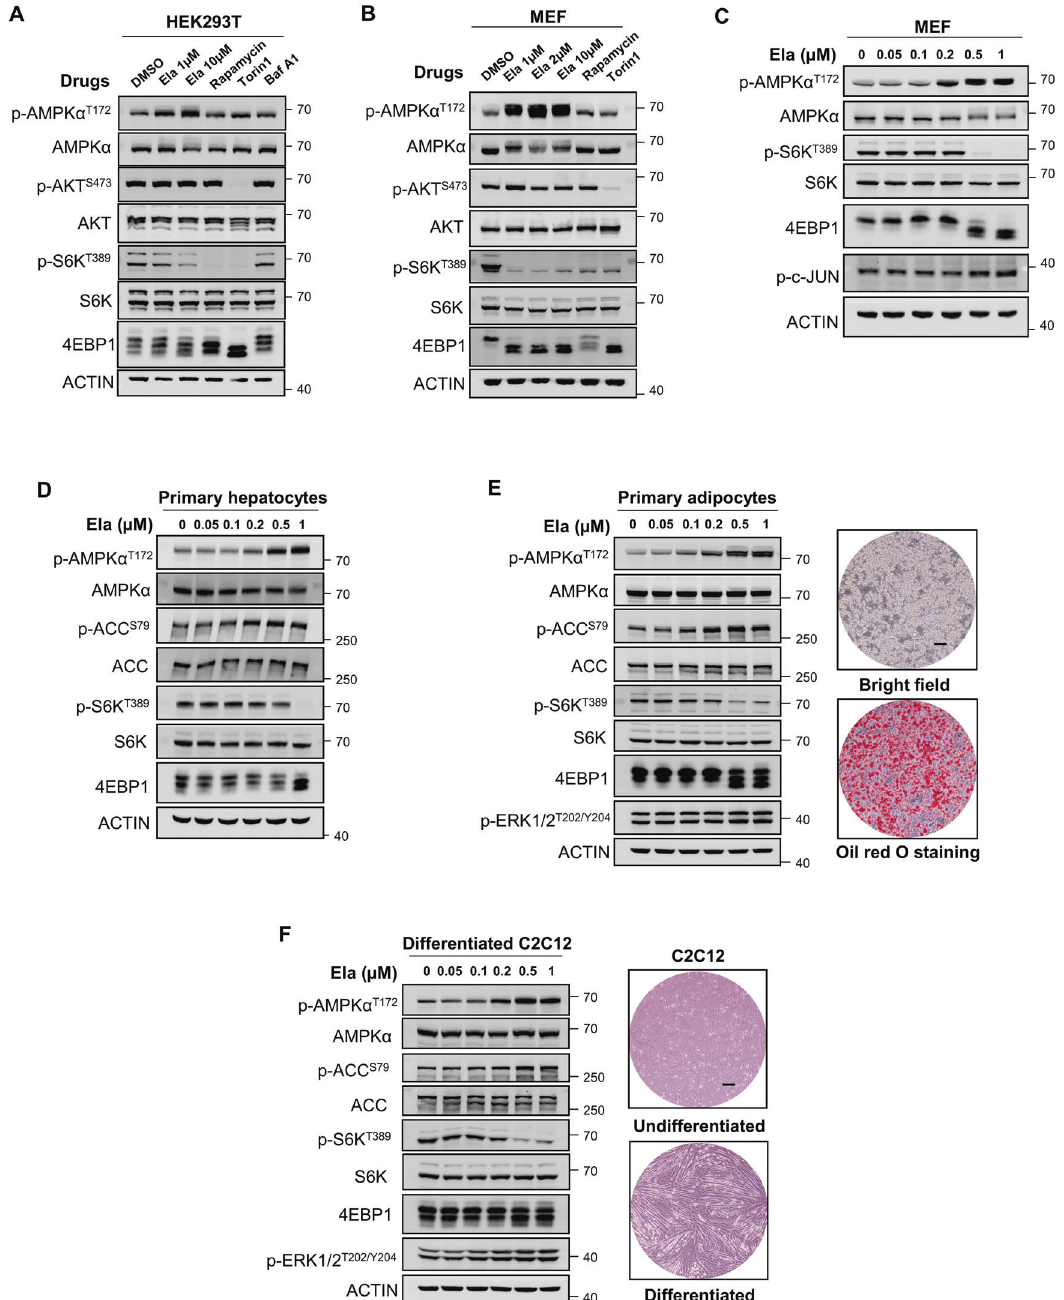
Fig. 4 Ela activates AMPK in multiple cell lines. A HEK293T cells were treated with DMSO, Ela (1 μ M), Ela (10 μ M), mTORC1 inhibitor Rapamycin (0.1 μ M), mTORC1/2 inhibitor Torin1 (0.1 μ M), and autophagy inhibitor ba fi lomycin A1 (0.1 μ M) for 3 h, then cells were harvested, and p-AMPK α T172 , AMPK α , p-AKT S473 , AKT, p-S6K T389 , S6K, and 4EBP1 were detected by WB. B Mouse embryonic fi broblasts (MEFs) were treated with DMSO, Ela (1 μ M), Ela (2 μ M), Ela (10 μ M), Rapamycin (0.1 μ M), and Torin1 (0.1 μ M) for 2 h, then cells were treated with Ela at the indicated concentration for 1 h. Later, cells were lysed and applied for WB. C Mouse embryonic fi broblasts (MEFs) were treated with Ela at the indicated concentration for 1 h, then cells were harvested and followed by WB. D Primary hepatocytes were isolated from wide-type C57BL/6 mice liver by two-step perfusion and then treated with Ela at the indicated concentration for 1 h. Cells were then lysed and followed by WB analysis. E Precursor cells were isolated from wide-type C57BL/6 mice inguinal white adipose tissue and induced to differentiation while the differentiation rate was shown by oil-red O staining. The mature primary adipocytes were treated with Ela at the indicated concentration for 1 h and followed by WB analysis. Scale bar, 100 μ m. F Mouse myoblast C2C12 was induced to differentiation, and C2C12 myotubes were treated with Ela for the indicated concentration for 1 h. Cells were then harvested and applied for WB. Scale bar, 100 μ we uncovered Ela as a novel AMPK activator. In two obese mouse 2 diabetes, and cardiovascular disease [31, 32]. Metabolic changes models, Ela functions as an effective compound in alleviating the induced by AMPK through the regulation of fatty acid and glucose clinical signs of obesity syndromes such as lowering glucose metabolism are bene fi cial in these conditions [33]. In this study,